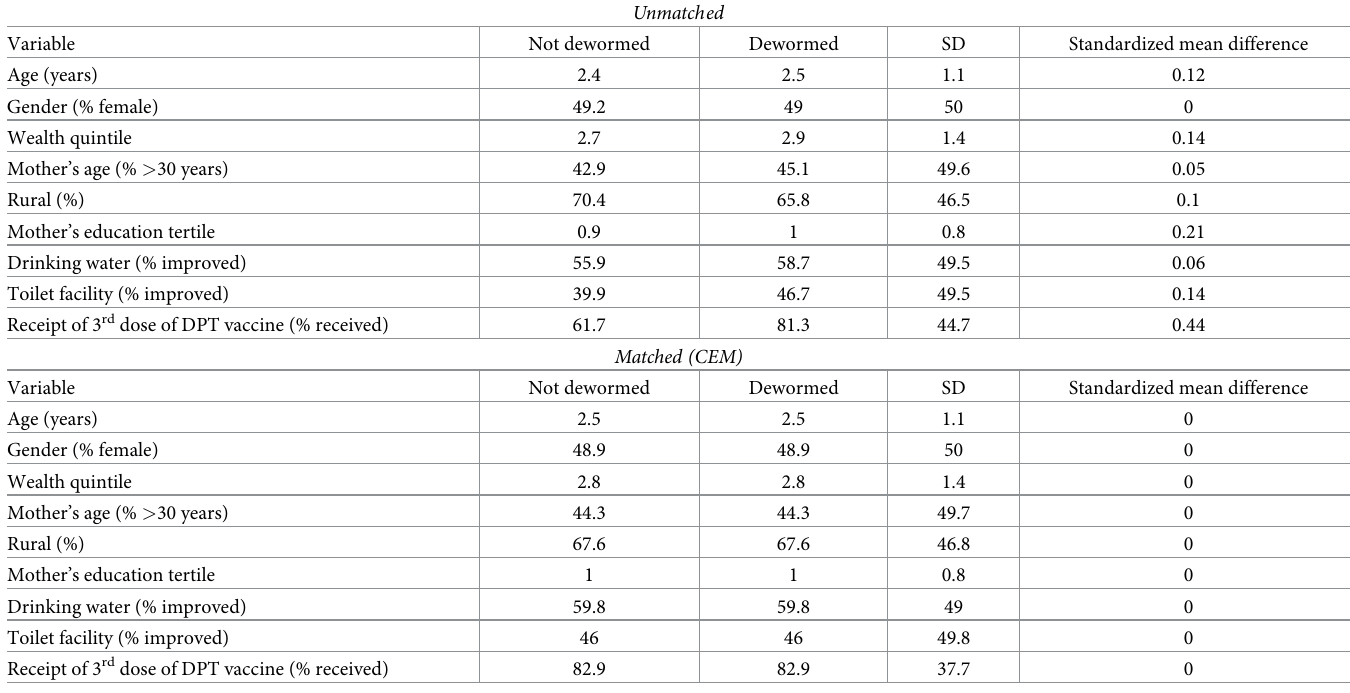
Table 2. Characteristics of pre-school age children stratified by receipt of deworming, unmatched and CEM matched groups. Unmatched Variable Not dewormed Dewormed SD Standardized mean